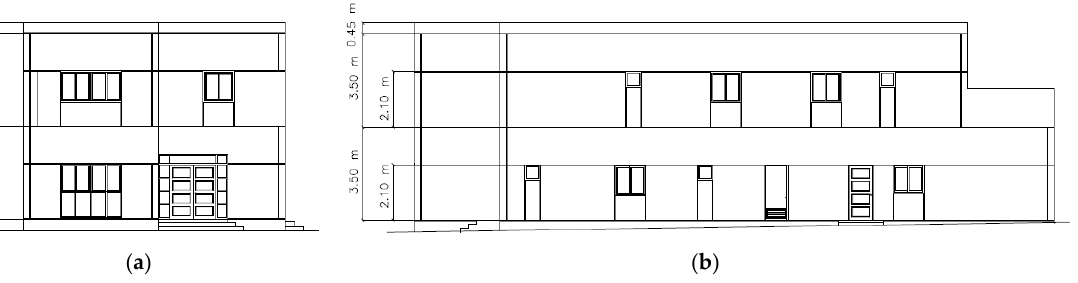
Figure 3. Building floor plans. ( a ) Ground floor; ( b ) First floor.